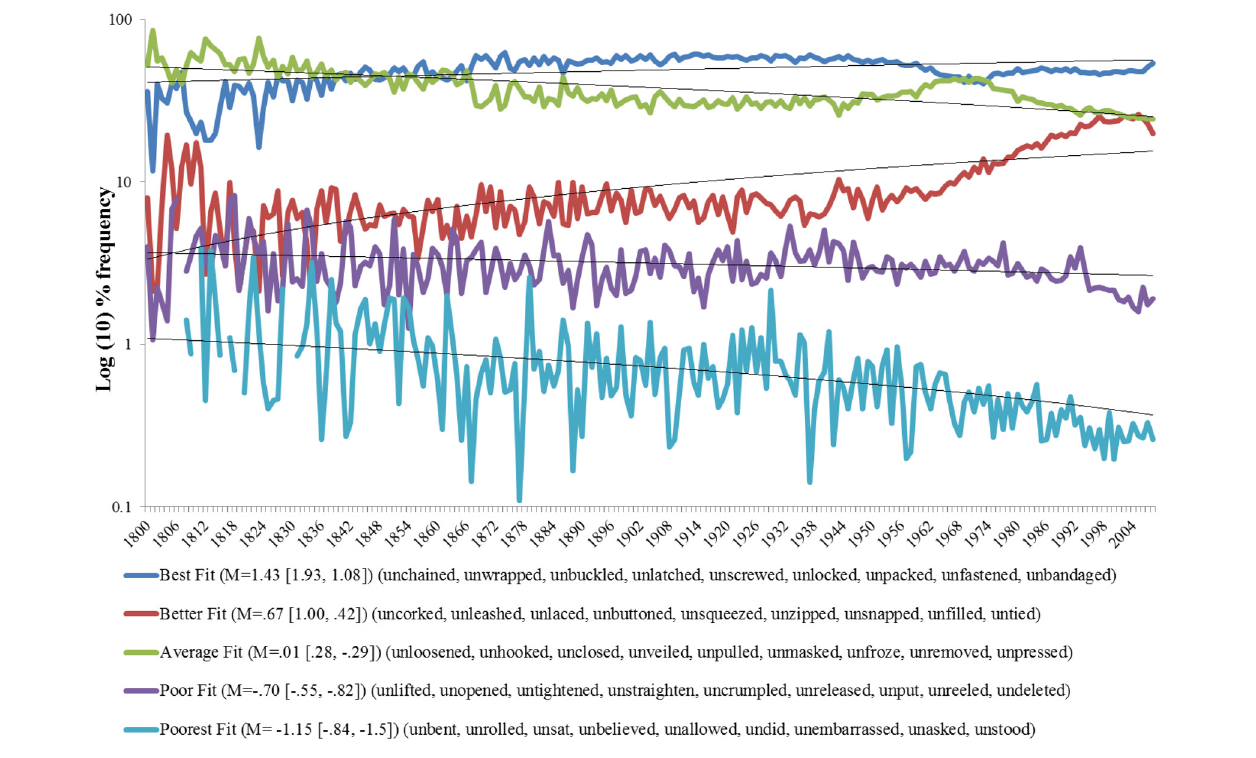
FIGURE 2 | Historical trends of un-forms ( N = 828 , 813) as a function of semantic rating. M = mean semantic rating for the nine verbs in each group, ranges are in square parentheses, verbs in curly parentheses. Note the y-axis is relative frequency, thus at any slice on